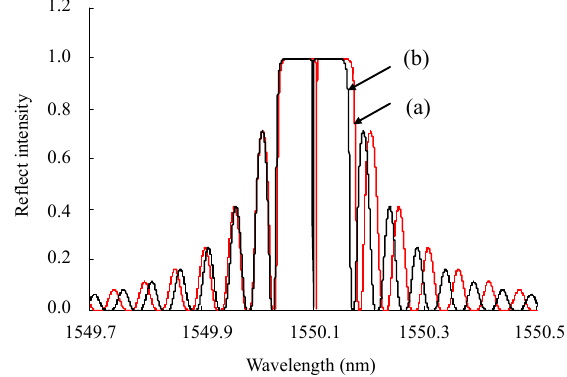
Fig. 2 Phase shift grating spectrum of the DFB fiber laser in a symmetric perturbation field n eff = 1.449: (a)  =0.2. n